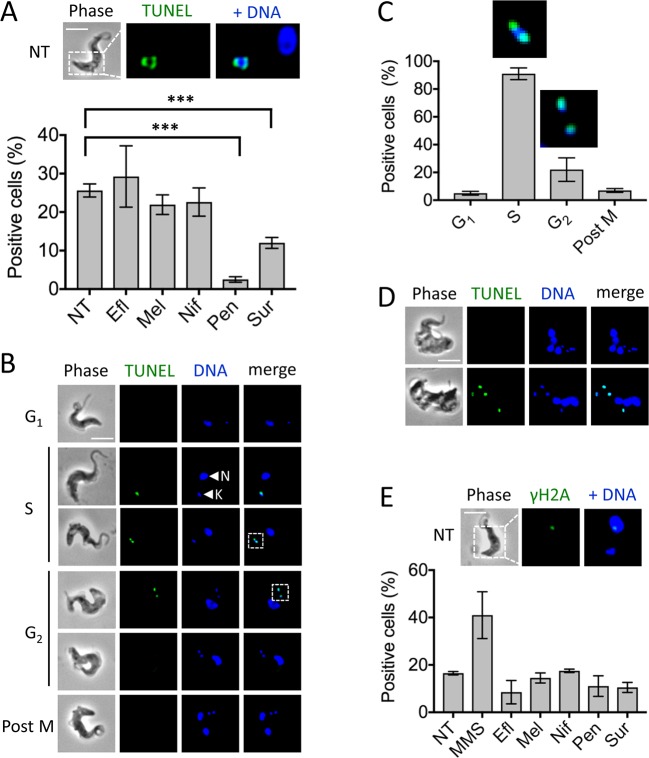
Assessment of ‘DNA-breaks’ in nuclei and gaps in kinetoplast circles.(A) Percentage of cells positive for a TUNEL signal. ***, P < 0.001 from Students t-test. The microscopy images show an example of the kinetoplast-associated TUNEL signal in NT cells. (B) Example images of TUNEL signals, always associated with the kinetoplast (k) rather than the nucleus (n), at different cell cycle stages; G1, S, G2 and post M (post mitotic). Dashed boxes indicate magnified regions shown in C. (C) Percentage of cells in each cycle stage positive for TUNEL signals, inset images show magnified signals from B as indicated by dashed boxes. (D) Examples of TUNEL signals in none or all four kinetoplasts following suramin treatment. (E) Percentage of cells positive for γH2A signals. The microscopy images show an example of the nuclear γH2A signal in NT cells. MMS, methyl methanesulfonate. Other details in A, C and E as in Fig 2A; error bars, SD; N = 2; all scale bars, 5 μm.